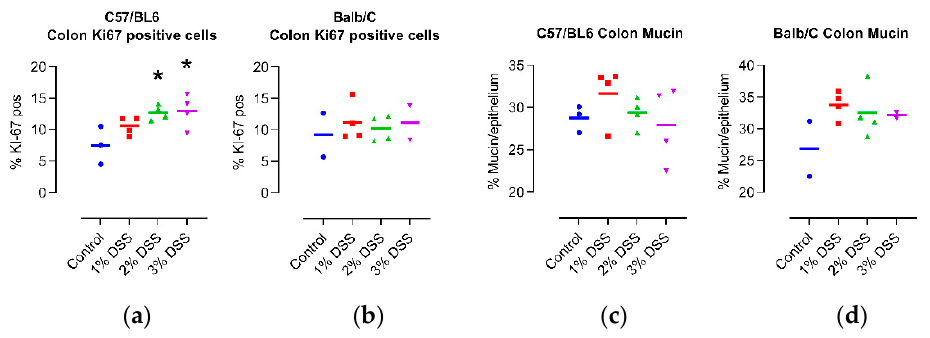
Figure 2. Effect of DSS treatment on percentage of Ki67 positive cells (a, b), and mucin content (c, d) in colons of 14-month-old female C57/Bl6 and Balb/C mice with CAC induced by 3 different con- centrations of DSS. Control = untreated control mice of the same age. N=2 – 4. * p < 0.05, ANOVA with Dunnett post hoc test vs. Control for C57/Bl6. Statistical correlation analysis is provided in Figure 3.